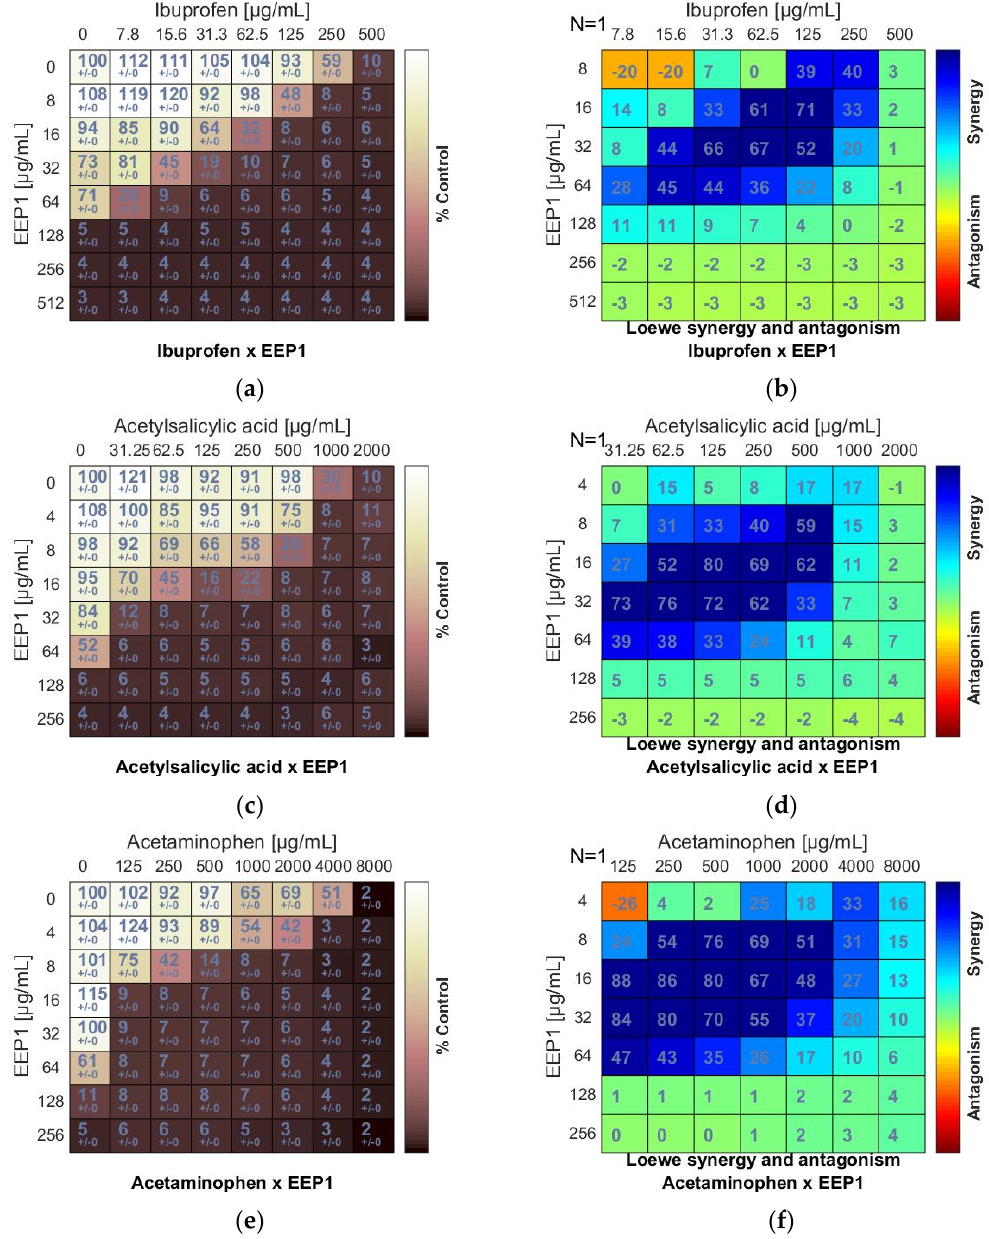
Figure 3. Synergistic effect between ethanolic extract of propolis and antipyretics against S. aureus ATCC 25923: ( a , c , e ) Checkerboard assay results showing the percentage growth inhibition compared with control; ( b , d , f ) Results showing synergy/antagonism calculations of synergy scores (the difference between the predicted additivity and the observed viability) for the Loewe model. A heat map represents the level of synergy (blue color) at each concentration. A positive score indicates synergy, a score of 0 is additive, and a negative score indicates antagonism (red color).